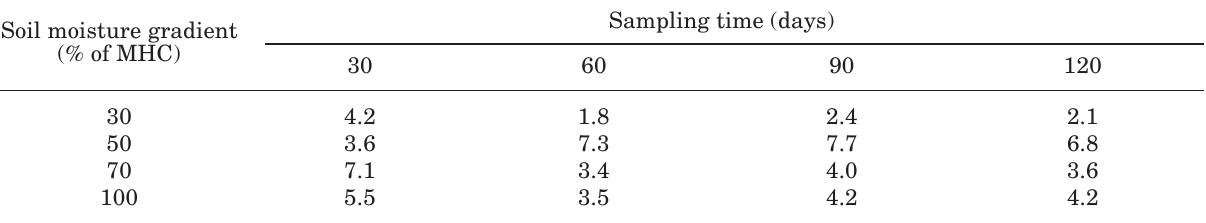
Table 2. Effect of soil moisture gradient on the population of Aspergillus versicolor ( (cid:1) 10 8 g -1 soil) a . Soil moisture